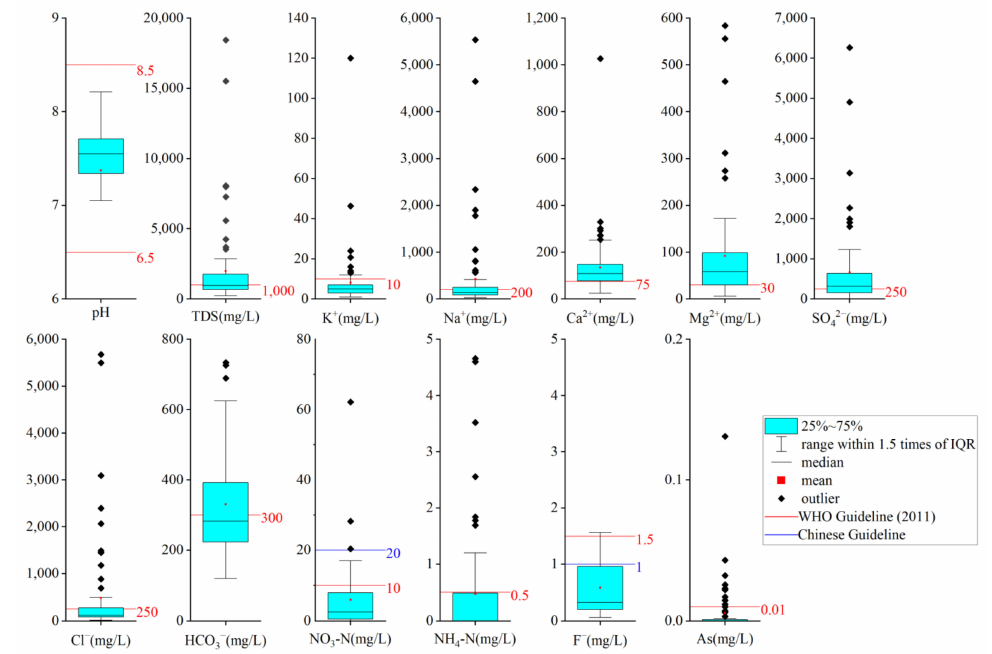
Figure 2. Box diagram of major chemical parameters in